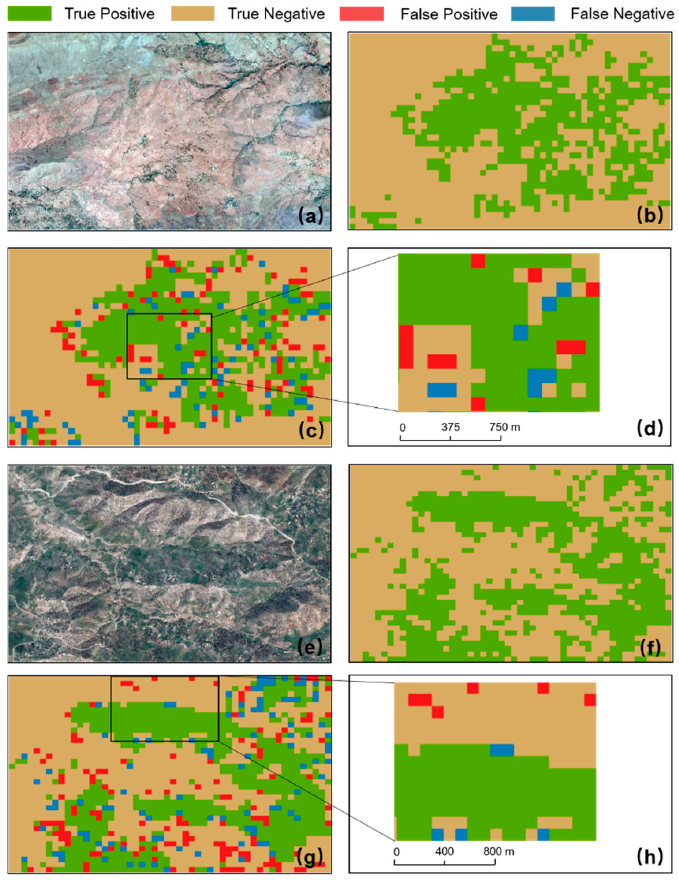
Figure 9. Olive mapping results using the region sampling approach and DG imagery. The legend only applies to ( c , d , g , h ). ( a ) RGB imagery in semi-arid site 5; ( b ) classification map in semi-arid site 5; ( c ) classification map showing TP/TN/FP/FN in semi-arid site 5; ( d ) classification map showing TP/TN/FP/FN in grid 5, semi-arid site 5; ( e ) RGB imagery in sub-humid site 9; ( f ) classification map in sub-humid site 9; ( g ) classification map showing TP/TN/FP/FN in sub-humid site 9; ( h ) classification map showing TP/TN/FP/FN in grid 4, sub-humid site 9.